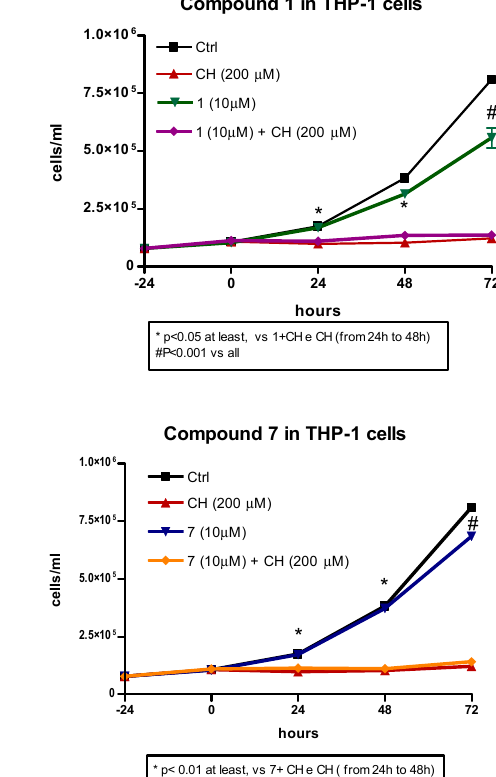
Figure 4. 3-(4,5-dimethylthiazol-2-yl)-2,5-diphenyltetrazolium bromide (MTT) spectrophotometric assay of compounds 1 , 5 , 6 , 7 , 11 , 12 at 10 to 40 µ M concentration in L6 cells in presence or absence of cumene hydroperoxide (CH, 27.5 µ M). Data are reported as mean values ± SD of each compound tested in quintuplicate. Statistical analysis performed with one-way analysis of variance (ANOVA) and Bonferroni post-test. The analysis was carried out using the Prism 4 statistics program. Differences were considered significant at p < 0.05.